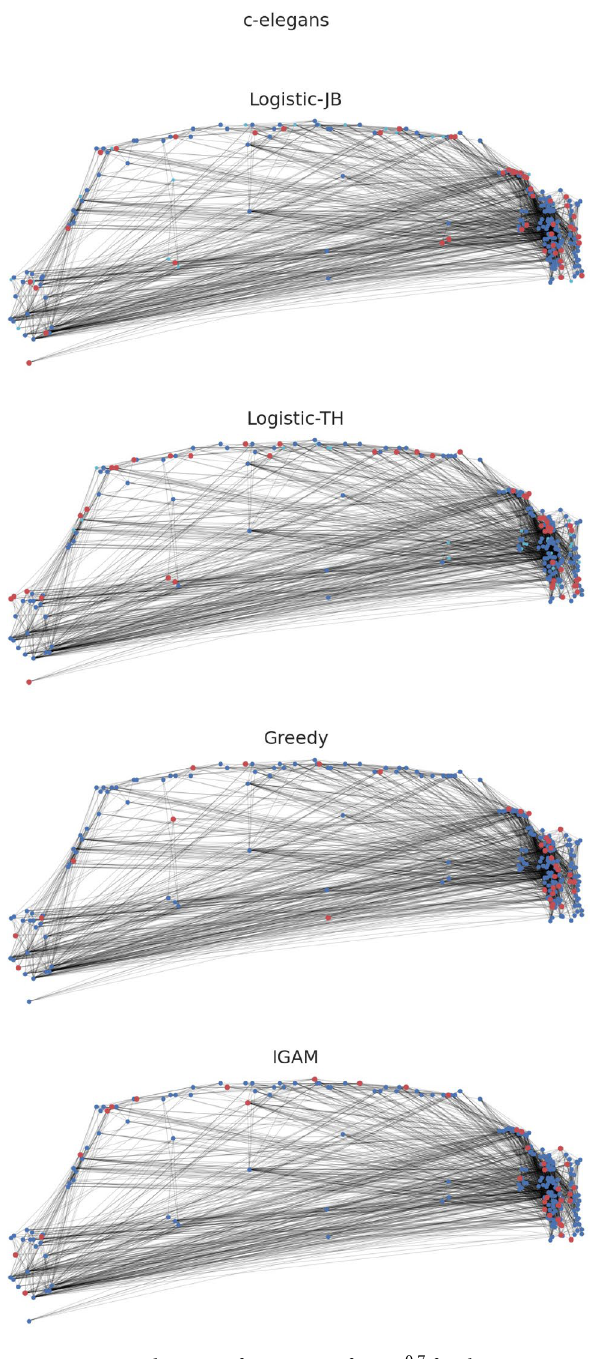
Figure 6. Visualization of a core set of size n 0.7 for the Logistic-JB, Logistic-TH, Greedy, and IGAM strategies. The red nodes represent members of the core set, the blue nodes are dominated nodes, and the cyan nodes are non-dominated nodes. Source code to reproduce the Figure can be found in Ref. 33